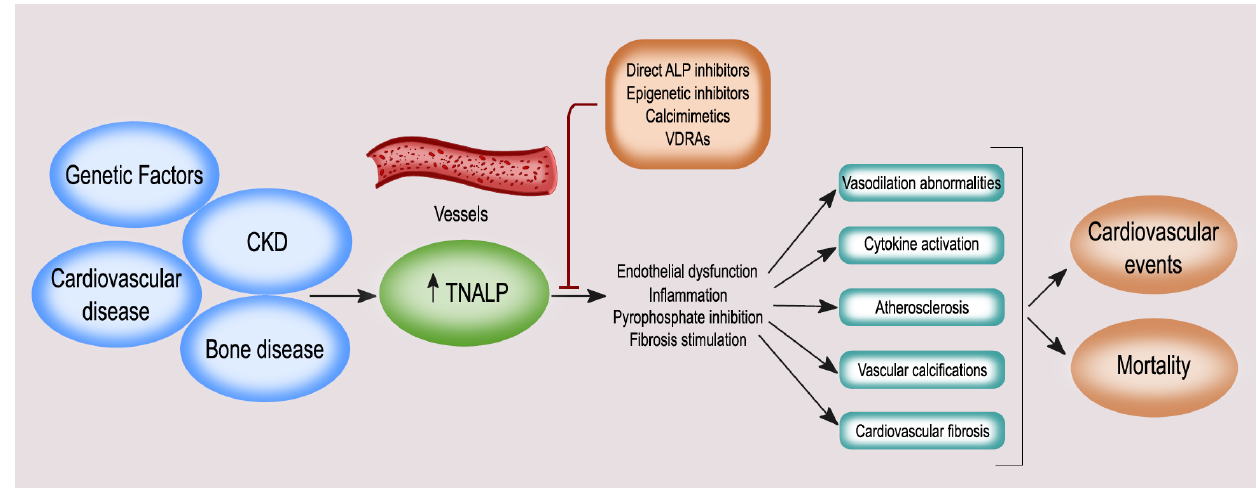
Figure 2. Roles of ALP in bone and cardiovascular disease.